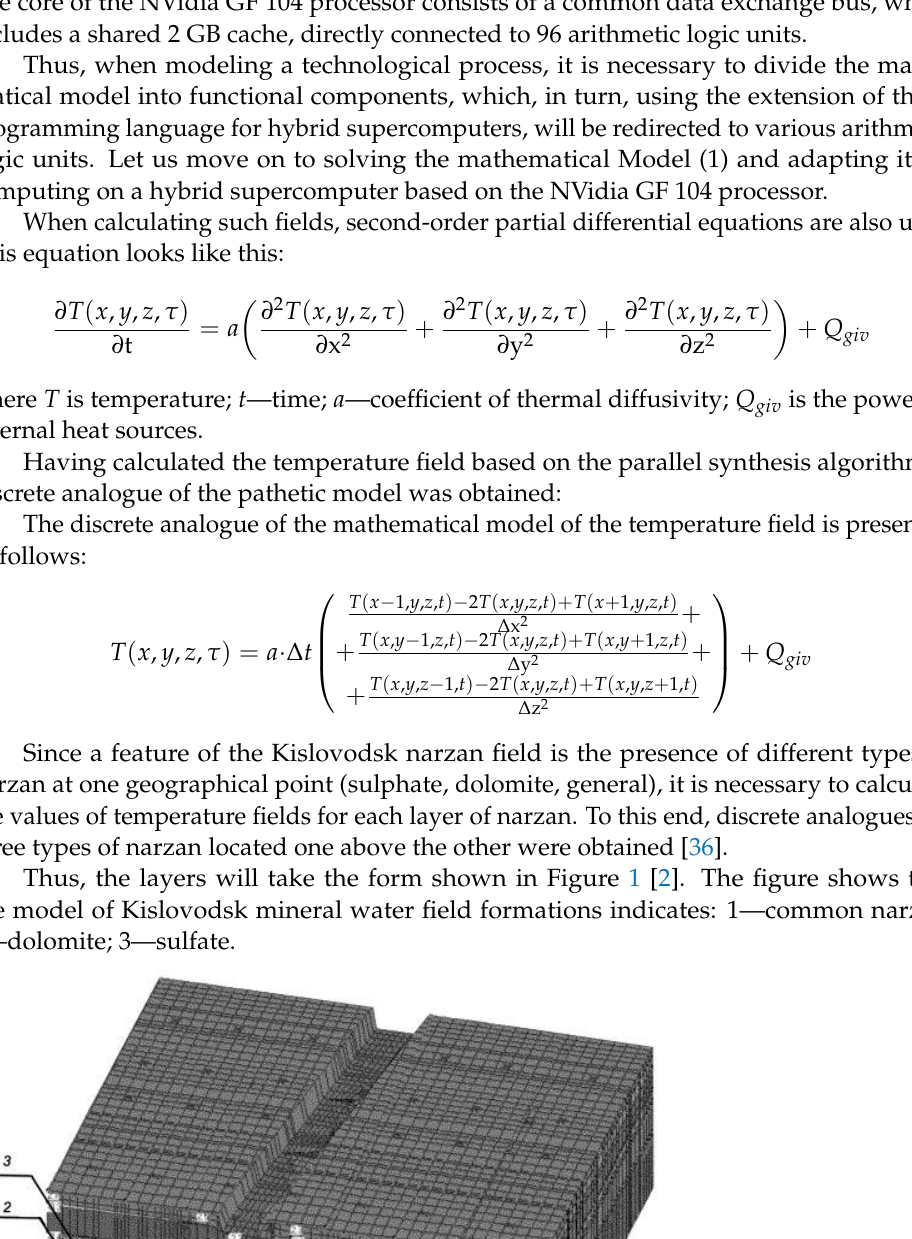
Algorithm 1. Fields temperature calculation.